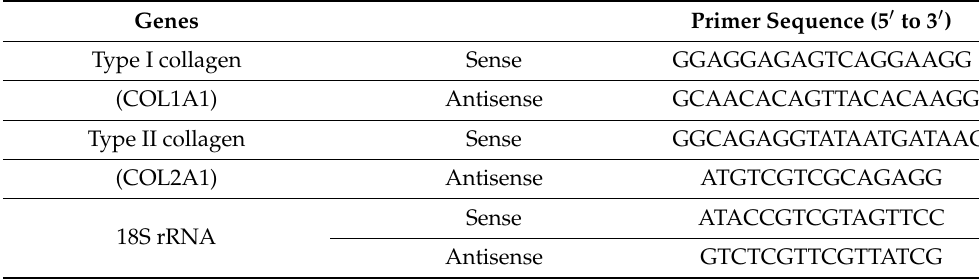
Table 3. Sequences of the primer sets for